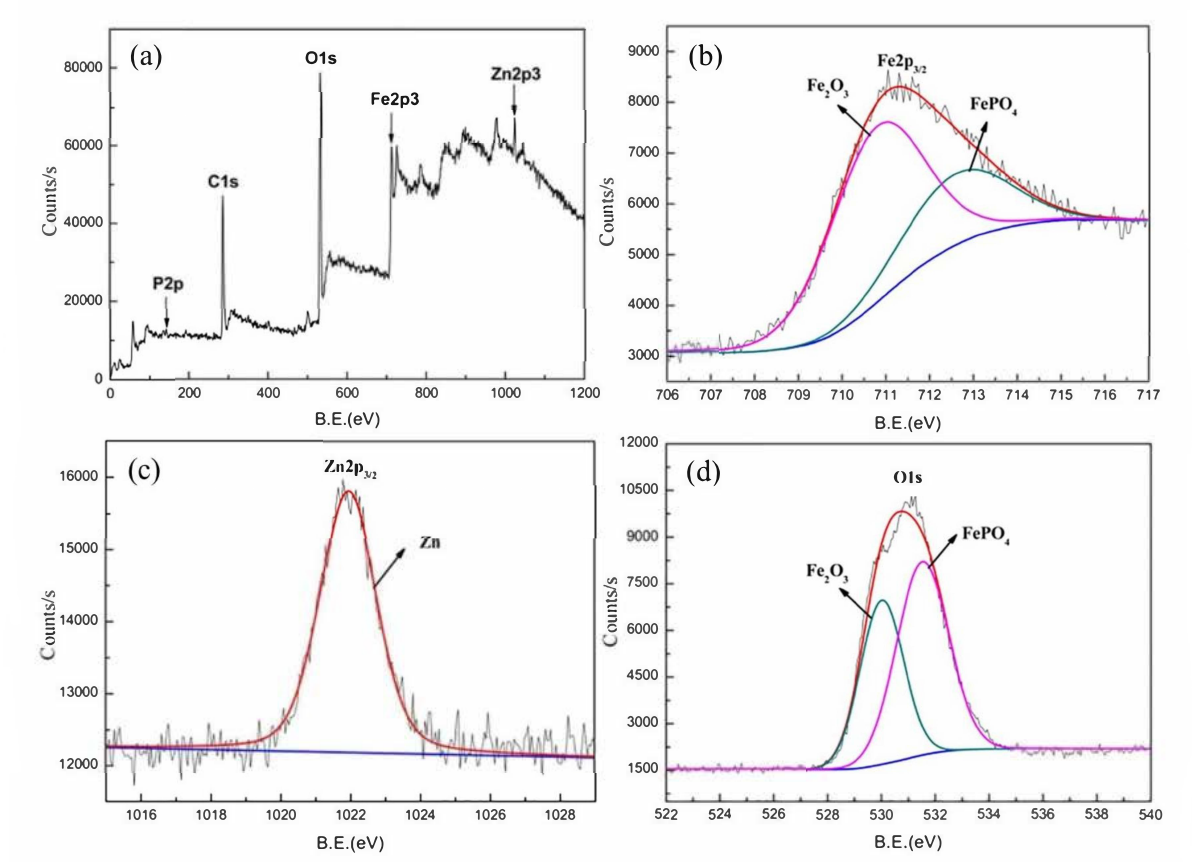
Figure 3. XPS surface analysis: ( a ) the XPS survey spectrum and the XPS spectrum of ( b ) Fe 2p 3/2 , ( c ) Zn 2p 3/2 , and ( d ) O 1 s for samples immersed in the PCC bath for 10 s [33]. Reproduced with permission from Jiang, C. et al., Electrochem. Commun.; published by Elsevier,